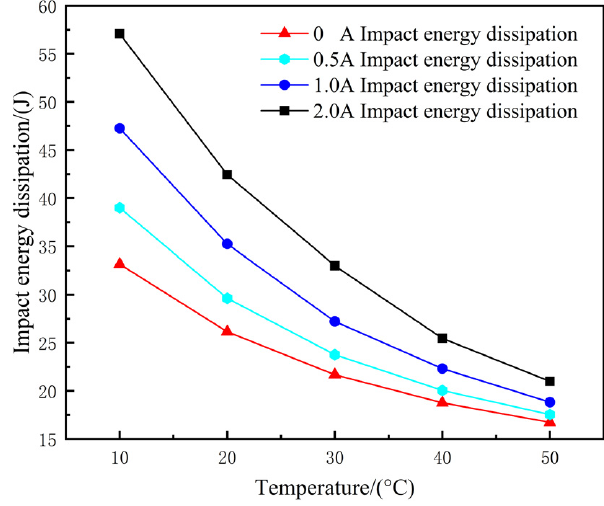
Figure 19. Effect of temperature on impact energy dissipation under impact condition.